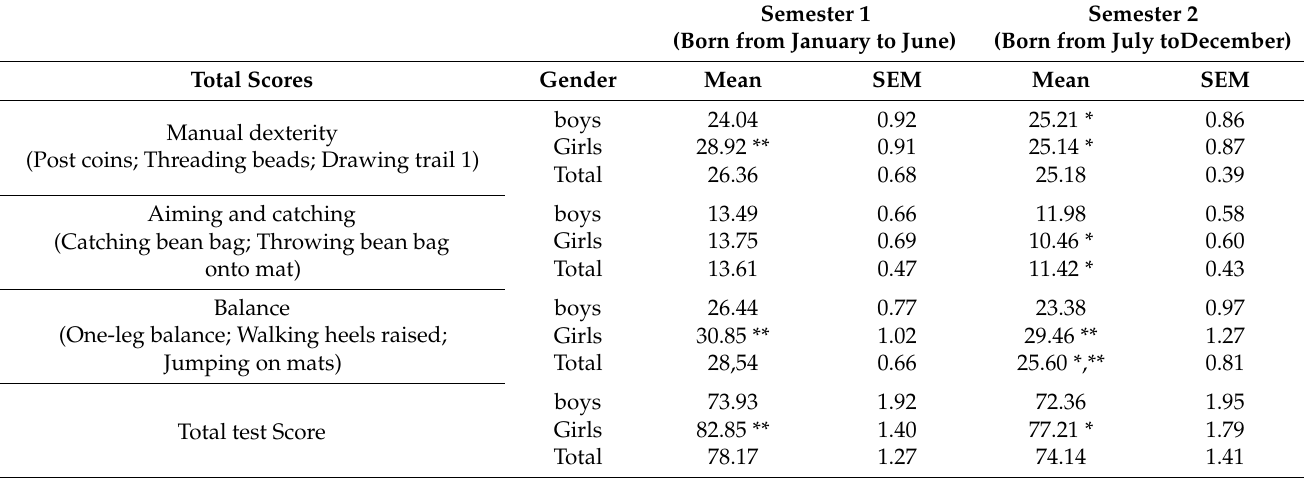
Table 1. Results of MABC-2 test based on gender and the semester of